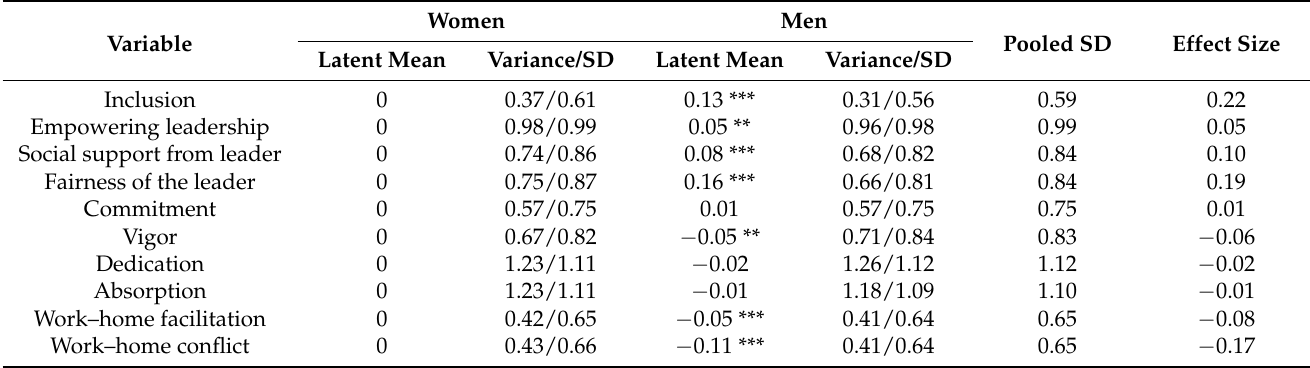
Table 3. Comparison of the means of the study variables for women and